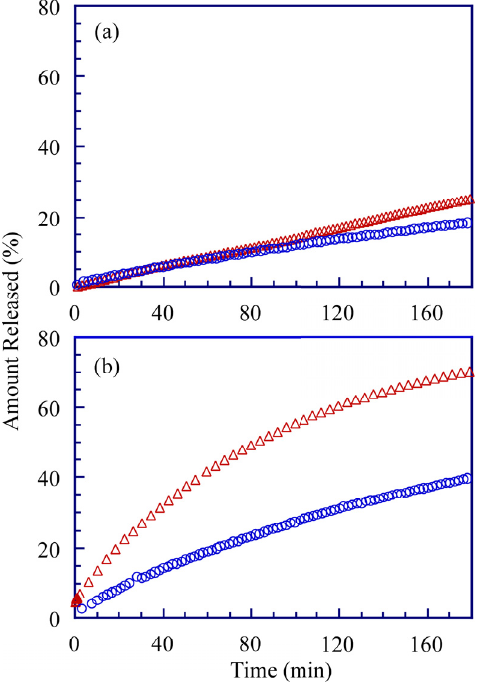
blank release ( △ ), ADR (0.06 mM) solution without polymer was released into 0.1 M NaCl aqueous solution. ADR solution with PMPC 0.1 M NaCl aqueous